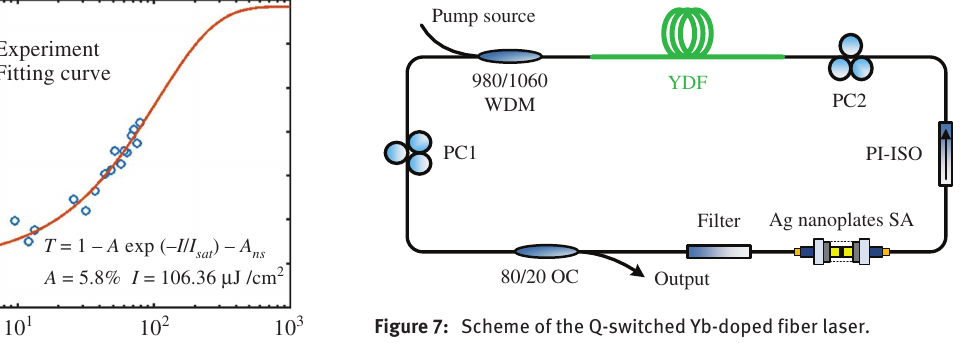
Figure 7: Scheme of the Q-switched Yb-doped fiber laser. WDM, wavelength division multiplexer; YDF, Yb-doped fiber; PC, polarization controller; PI-ISO, polarization-insensitive isolator; Filter, 1- μ m band pass filter; OC, optical